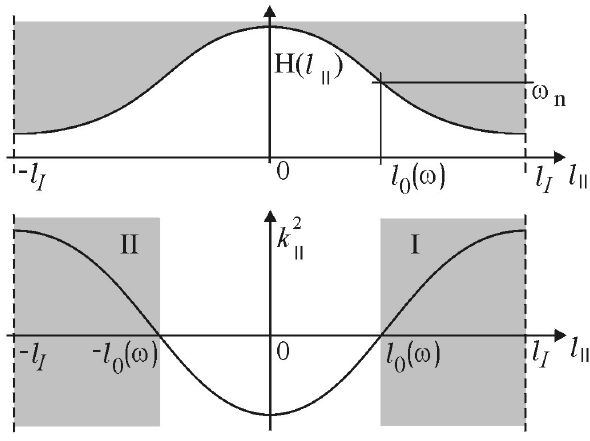
Fig. 1. Sketch demonstrating the dependence of H (top) and k 2 k (bottom) on l k and showing probable locations of the transparent and opaque regions. Here ± l 0 are the turning points for a harmonic with eigenfrequency ω n , ± l I are the intersection points of a field line with the ionosphere. The shaded areas I and II correspond to the transparent regions.